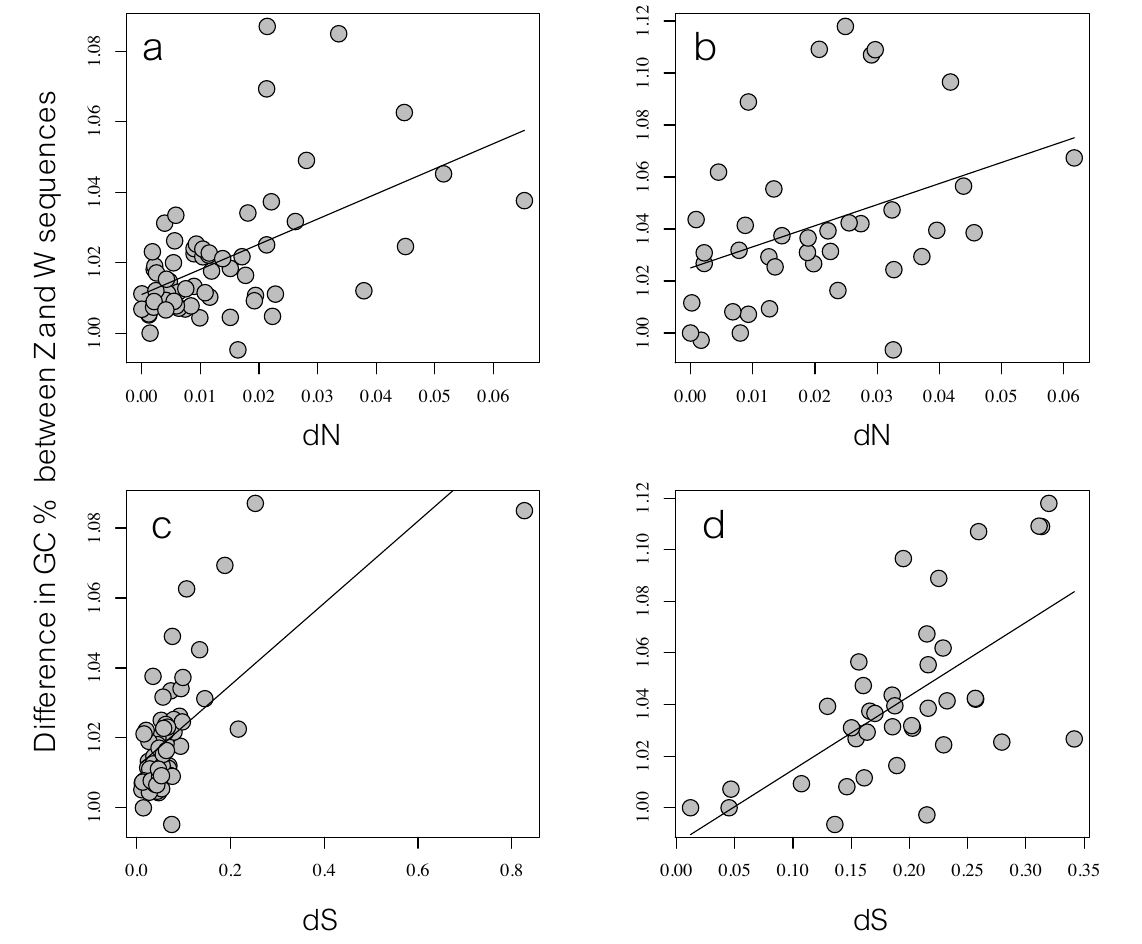
Figure 3. The difference in GC-content between the Z sequence and W sequence (Y axis) plotted against the sequence divergence (X axis) of common whitethroat gametologs. The panels show the Z-to-W GC-content and degree of functional divergence (dN) for ( a ) the neo-sex chromosome and ( b ) the ancestral sex chromosome, and non-functional (dS) divergence for ( c ) the neo-sex chromosome and ( d ) the ancestral sex